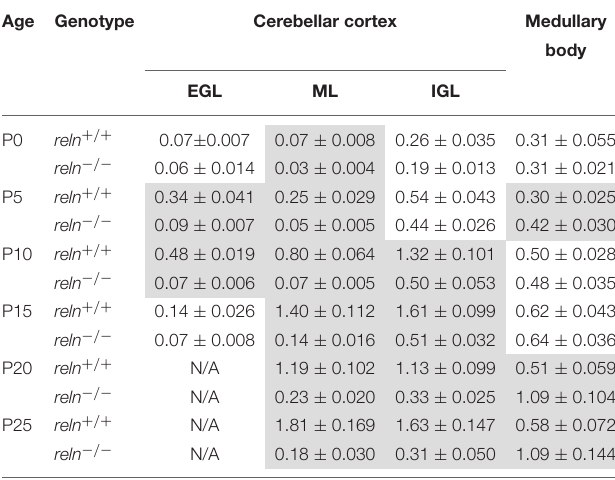
TABLE 1 | Statistical analysis of the areas of cortical layers and medullary